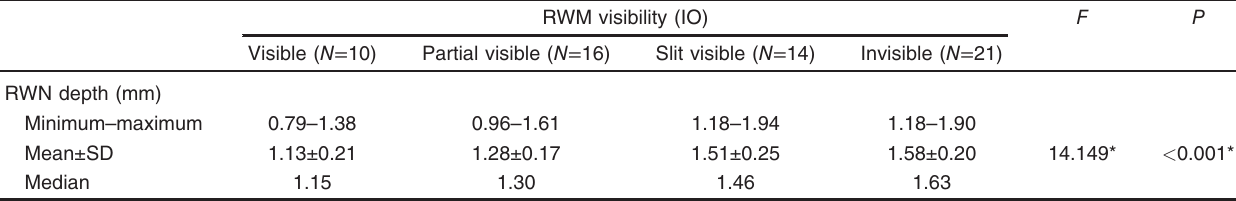
Table 4 Relation between round window membrane intraoperative visibility and round window membrane depth ( N = 61)